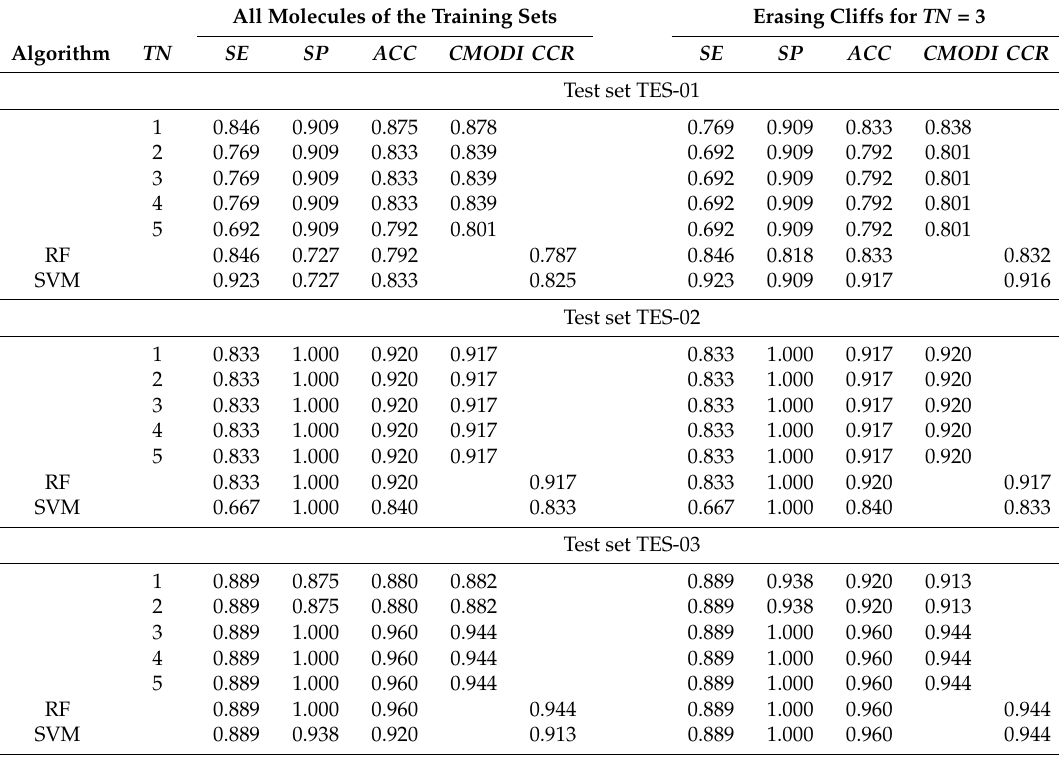
Table 3. Results of the predictions using CMODI for different values of TN and the algorithms for the three whole training sets and the training sets erasing the activity cliffs detected for TN = 3. All Molecules of the Training Sets Erasing Cliffs for TN =